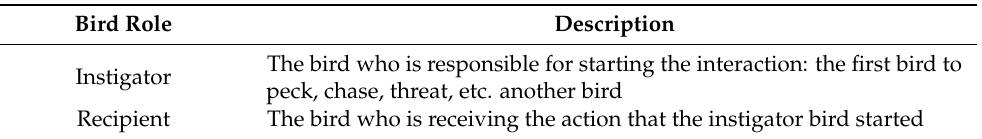
Table 5. Bird role in behavior observed continuously for 15 min at 1300 and 1600 h two days before the treatments were imposed.